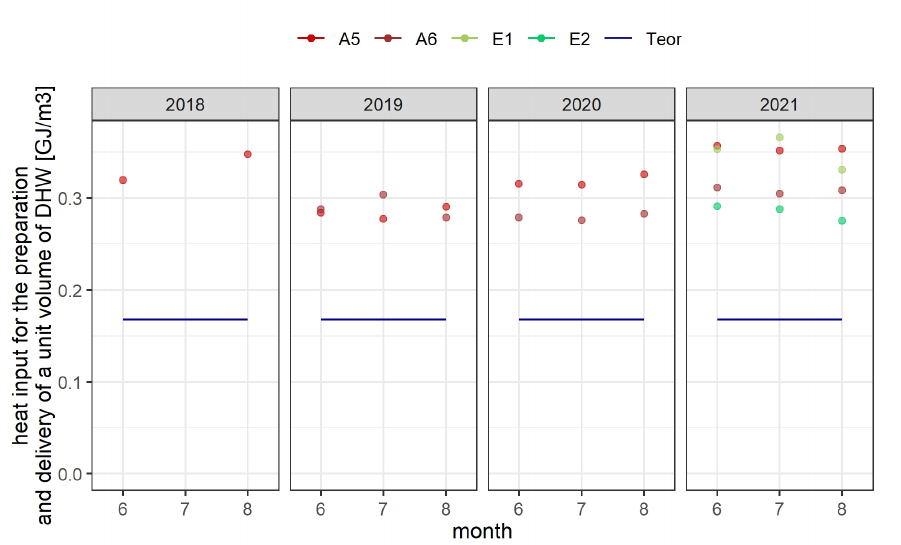
Figure 3. Comparison of the real and theoretical heat input for the preparation and delivery of a unit volume of domestic hot water in 4 heat supply systems in